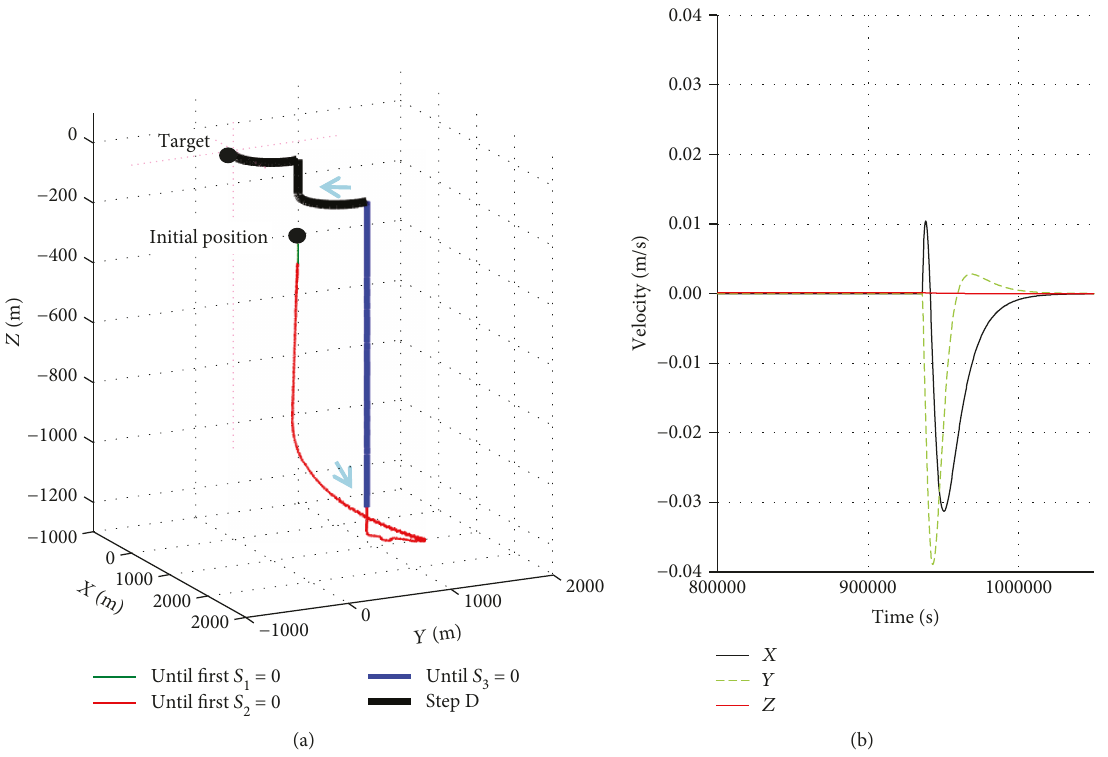
Figure 12: Position in case 2. (a) Position trajectory to the target. (b) Velocity histories around the target.